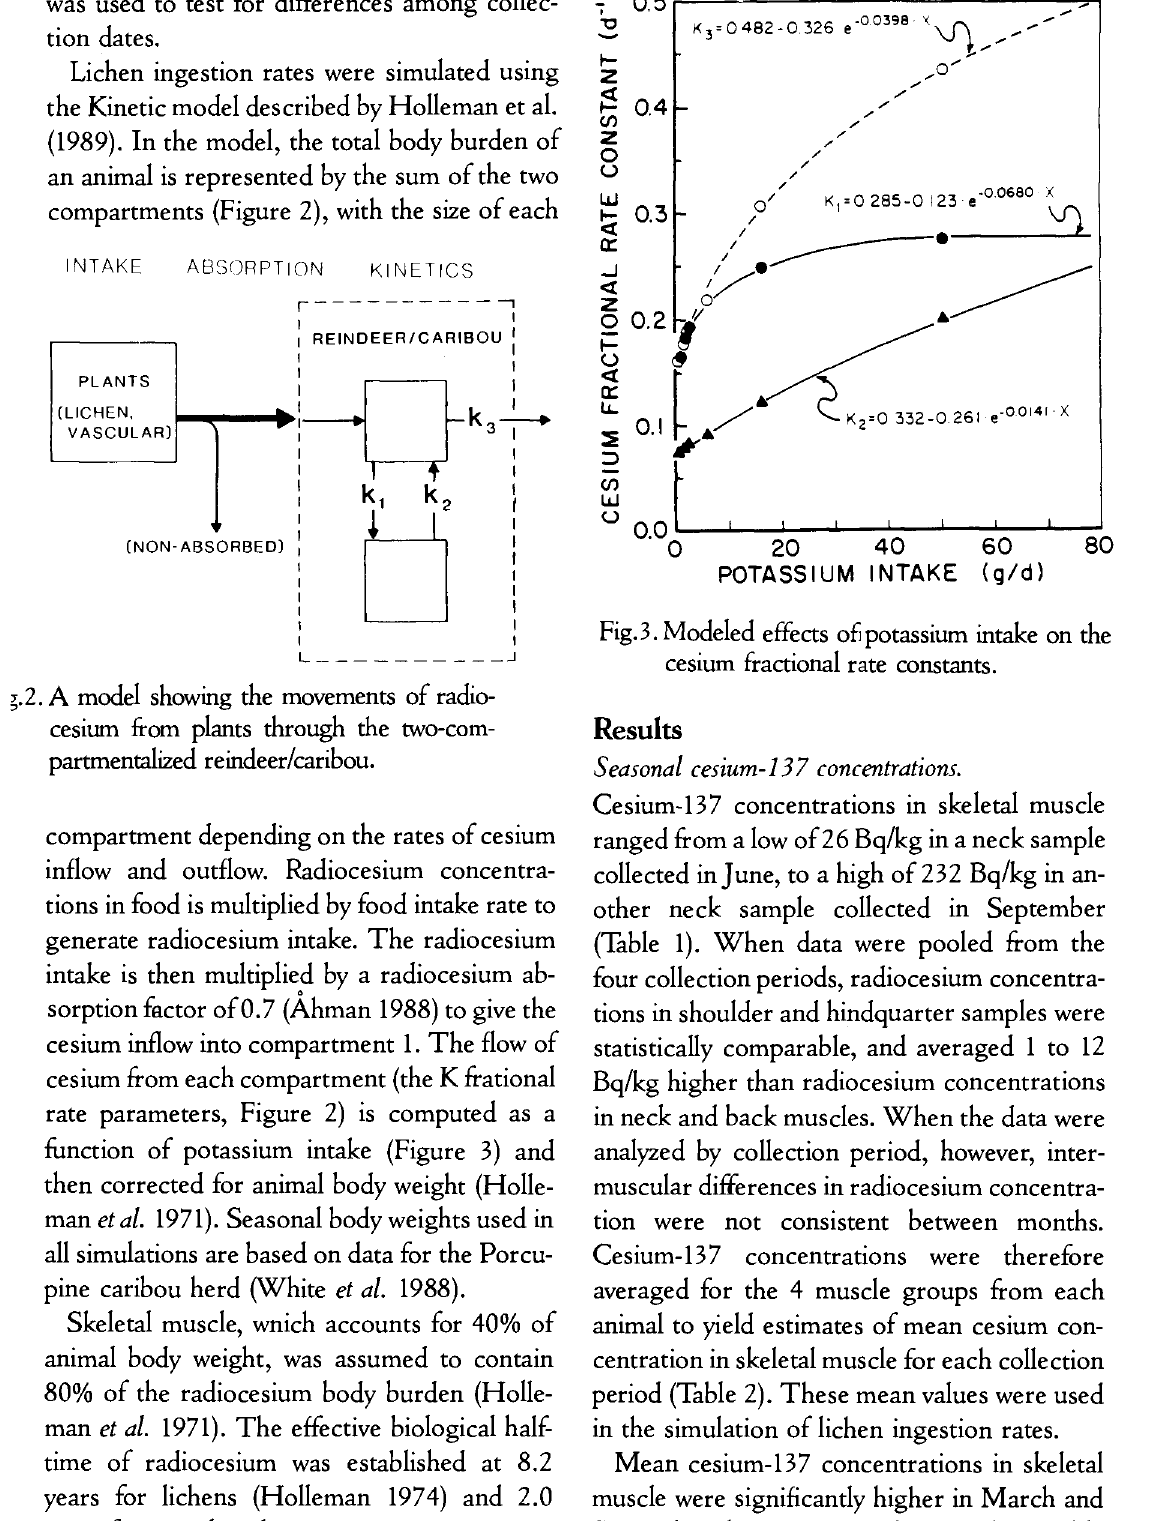
Fig. 3. Modeled effects of potassium intake on the cesium fractional rate constants. Results Seasonal cesium-137 concentrations. Cesium-137 concentrations in skeletal muscle ranged from a low of 26 Bq/kg in a neck sample collected in June, to a high of 232 Bq/kg in an other neck sample collected in September (Table 1). When data were pooled from the four collection periods, radiocesium concentra tions in shoulder and hindquarter samples were statistically comparable, and averaged 1 to 12 Bq/kg higher than radiocesium concentrations in neck and back muscles. When the data were analyzed by collection period, however, inter muscular differences in radiocesium concentra tion were not consistent between months. Cesium-137 concentrations were therefore averaged for the 4 muscle groups from each animal to yield estimates of mean cesium con centration in skeletal muscle for each collection period (Table 2). These mean values were used in the simulation of lichen ingestion rates. Mean cesium-137 concentrations in skeletal muscle were significantly higher in March and September than in June and November